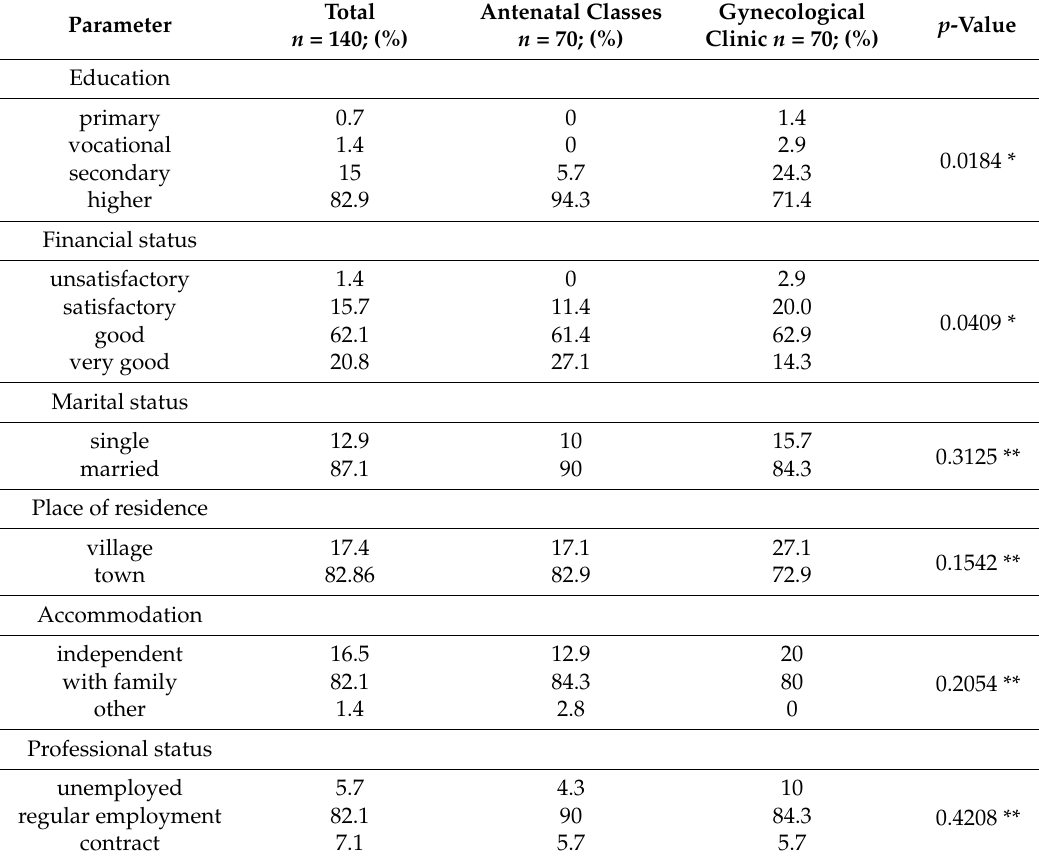
Table 2. Social and demographic characteristics of the pregnant women, in total and by